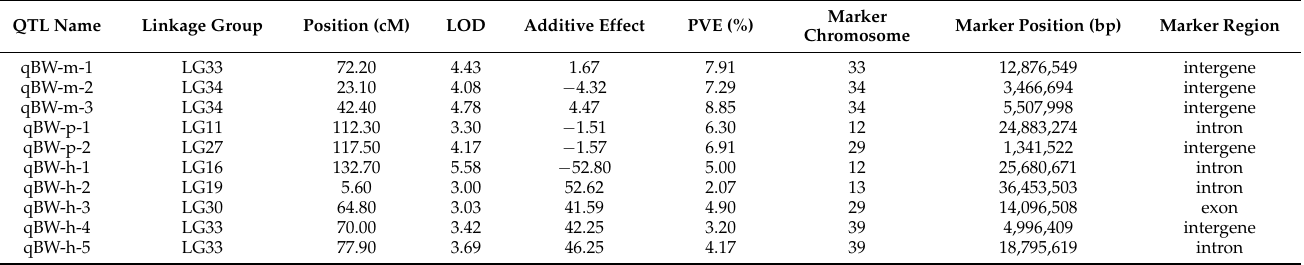
Table 5. Information on body weight-related QTLs in Yellow River carp at 5–9 months after hatching.